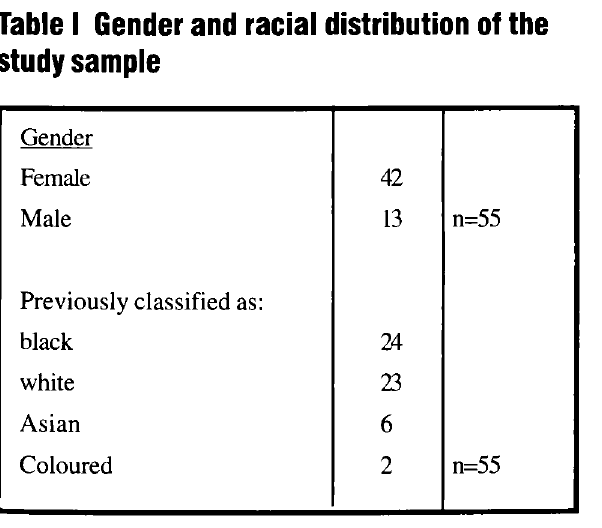
Table I Gender and racial distribution of the study sample